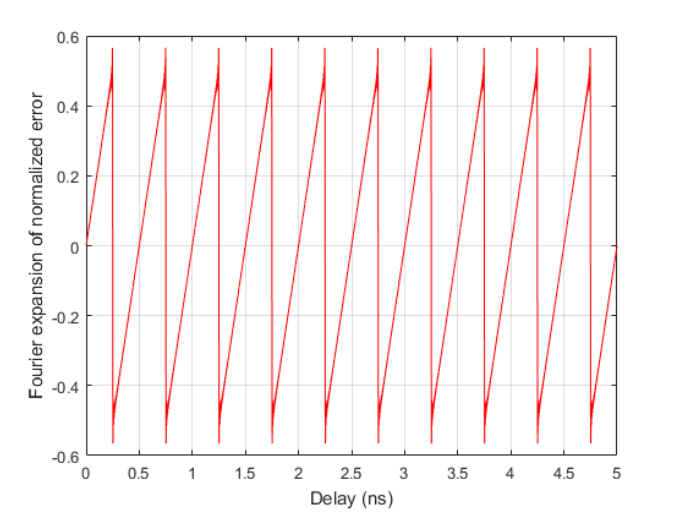
Figure 8. Reconstructed error